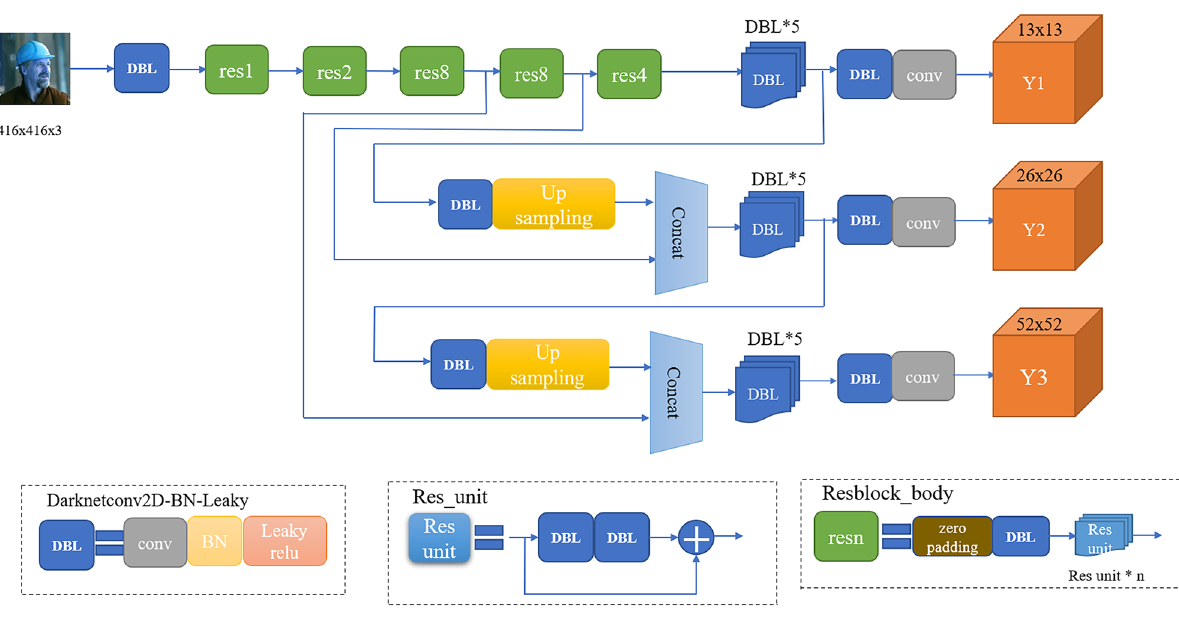
Figure 3. The network of